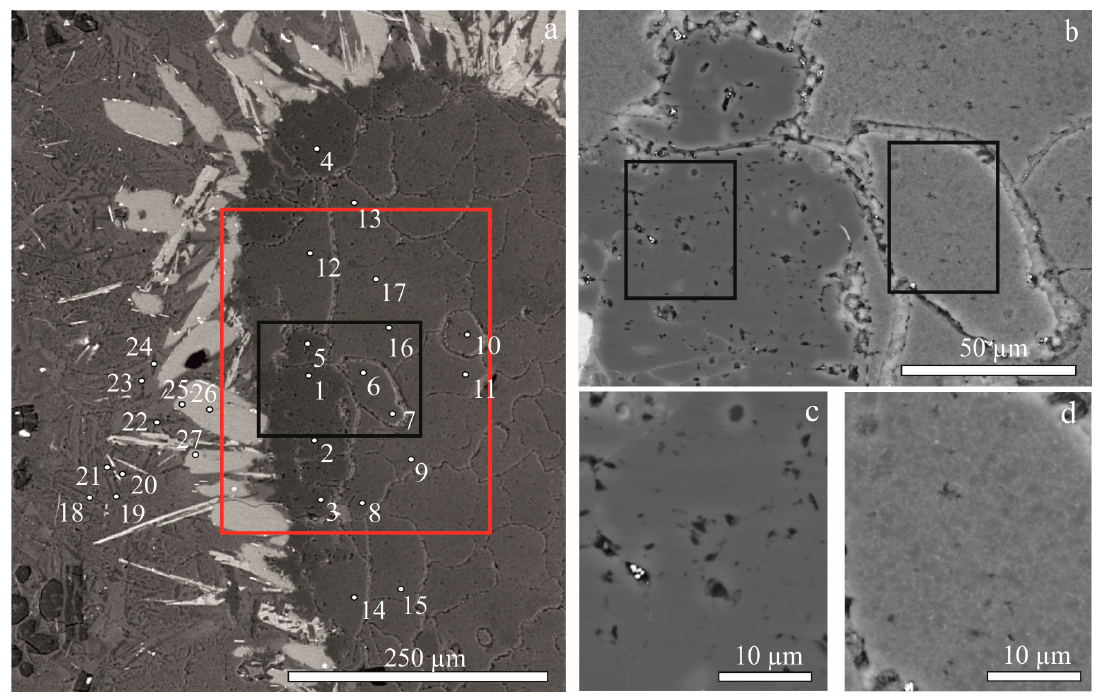
Figure 3. BSE images of ballen quartz obtained in thin section of sample (Jl-05) of impact melt rock from the Jänisjärvi impact structure. Black rectangles in ( a ) and ( b ) show positions of panels ( c ) and ( d ), respectively.